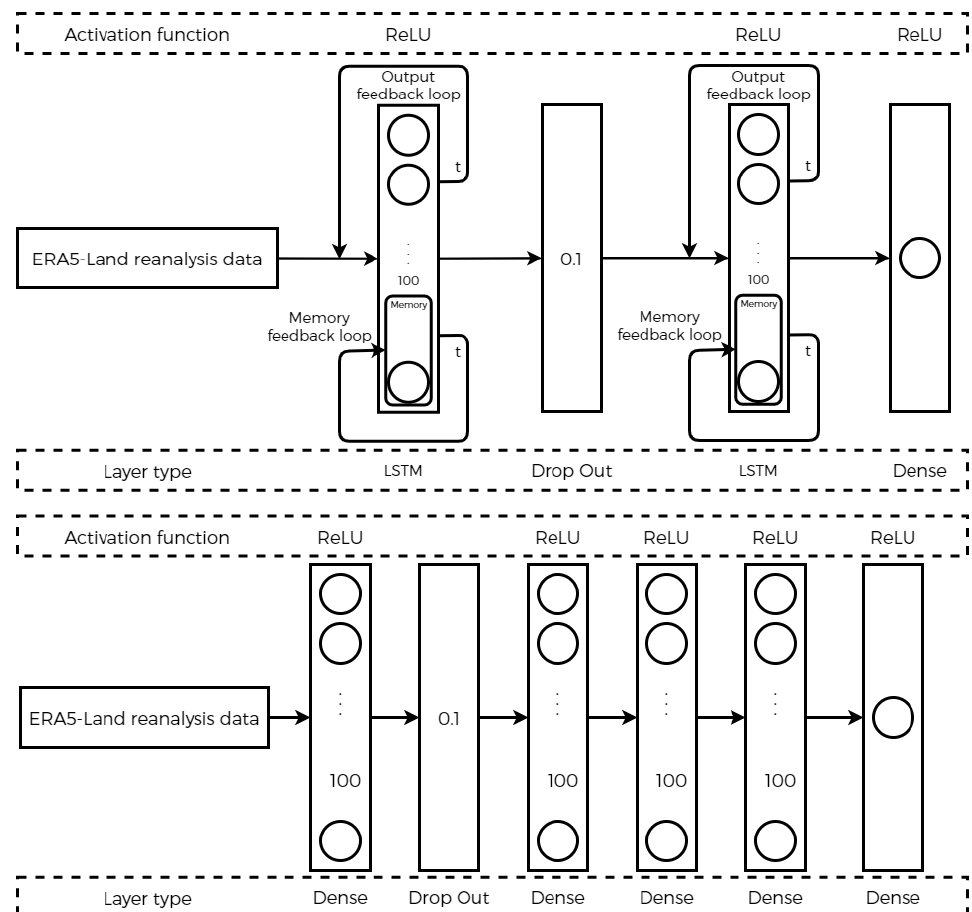
Figure 8. Architectures of FFNN and LSTM used in the